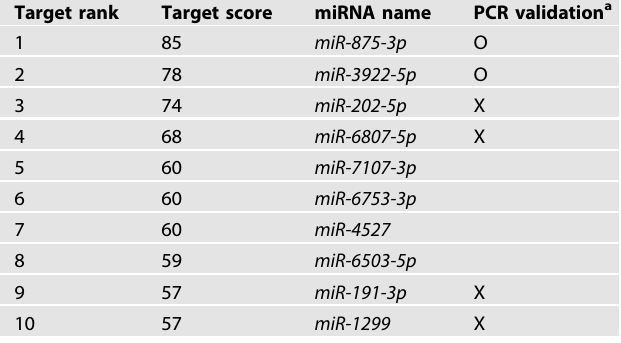
Table 1. The predicted NDRG1-OT1 sponged miRNAs by